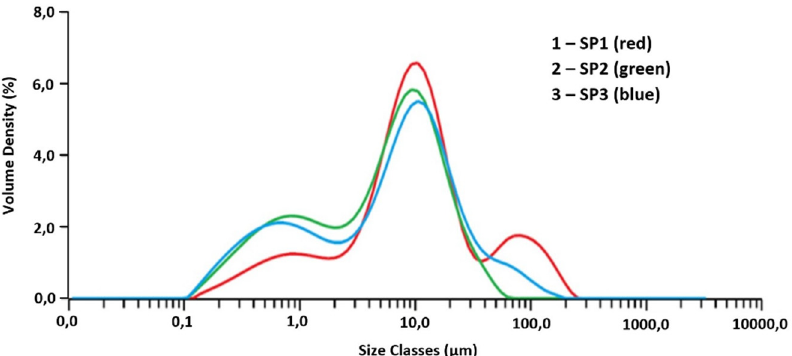
Figure 2. XRD patterns of ( a ) SP1 pigment (red color); ( b ) SP2 pigment (light brown color); and ( c ) SP3 pigment (dark brown color).